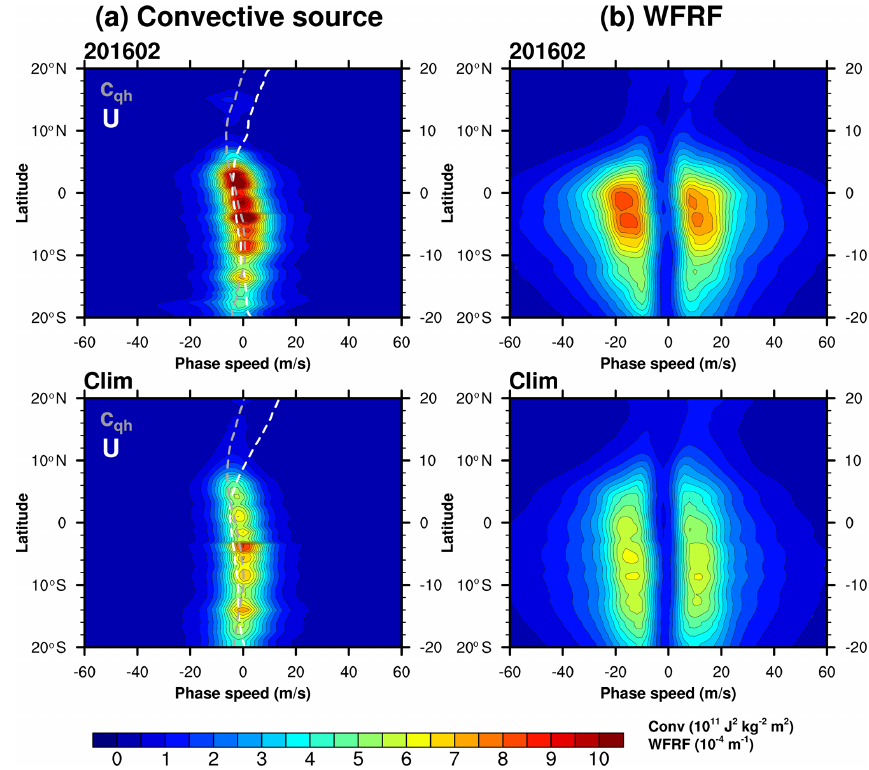
Figure 15. Latitudinal distributions of (a) the zonal mean convective source spectrum and (b) wave-filtering and resonance factor (WFRF) spectrum in (top) February 2016 and (bottom) the climatology. White and gray dashed lines in the convective source spectrum denote zonal-mean zonal wind ( U ) and the moving speed of convection ( c qh ), respectively.